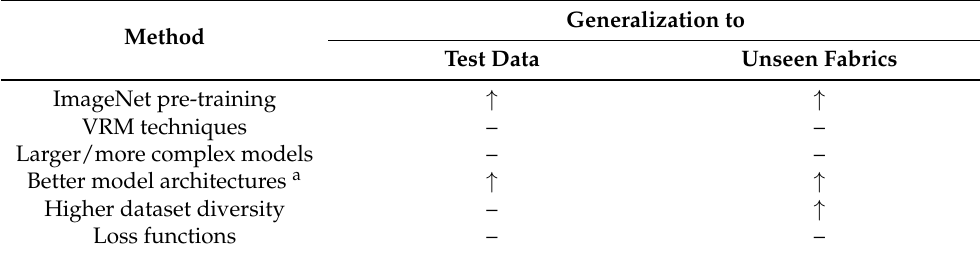
Table 9. High-level summary of trends identified for the generalization of supervised fabric AD methods. We denote positive influence of methods with ↑ , and negative as well as inconclusive influence with